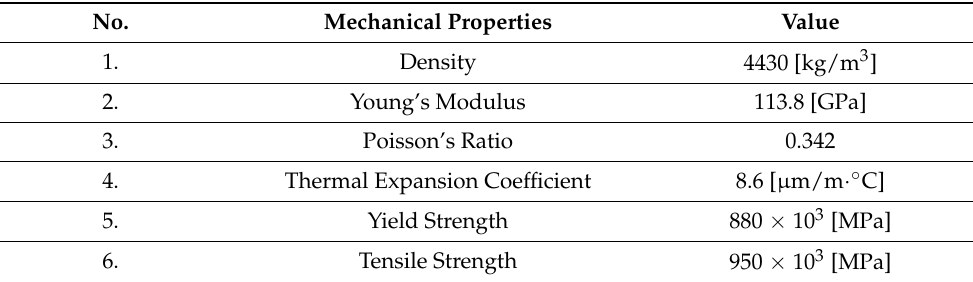
Table 1. Titanium alloy 6Al-4V mechanical properties